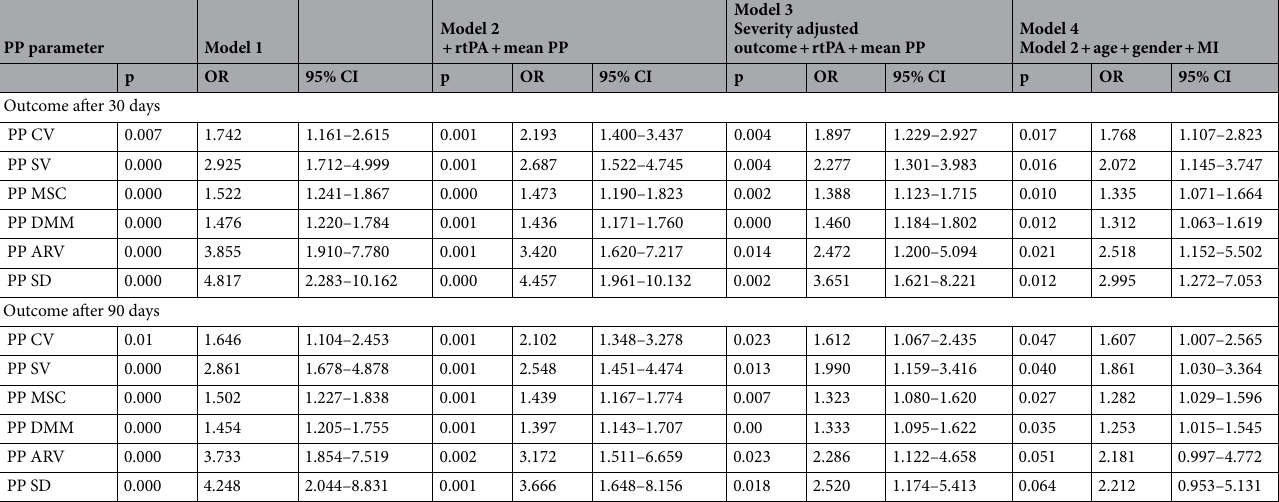
Table 3. Multivariate logistic regression analysis showing the PPV association with unfavorable outcome at 30- and 90-days post-stroke period. Model 1 unadjusted logistic regression, Model 2 adjusted to rtPA application and mean PP; Model 3 severity adjusted outcome adjusted to rtPA and mean PP; Model 4 adjusted to rtPA application, mean PP, age, gender and history of myocardial infarction. ARV: average real variability; CI: confidence interval; CV: coefficient of variation; DMM: difference maximum-minimum; MI: myocardial infarction; MSC: maximal successive change; OR: Odd’s ratio; PP: pulse pressure; PPV: pulse pressure variability; rtPA: recombined tissue plasminogen activator; SD: standard deviation; SV: successive